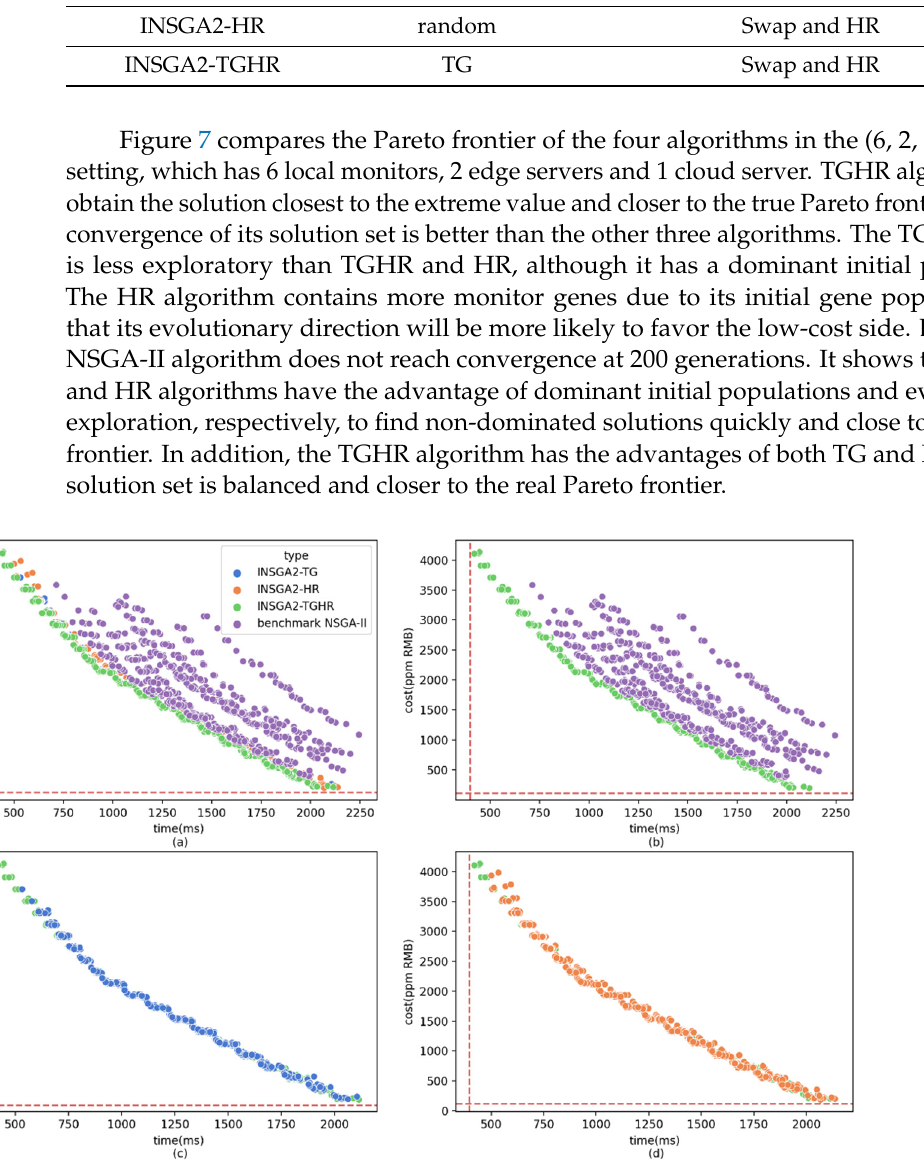
Figure 7. Comparison of Pareto frontier. ( a ) Comparison of four algorithms; ( b ) Comparison of TGHR and benchmark NSGA-II; ( c ) Comparison of TGHR and TG; ( d ) Comparison of a and TGHR and HR.